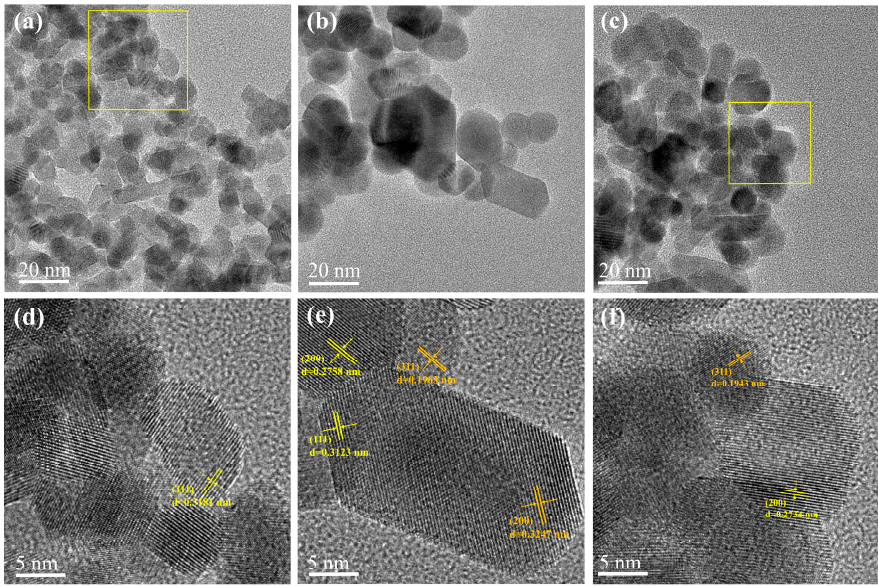
Figure 6. HRTEM of fresh samples ( a , d ) for CeO 2 ; ( b , e ) for 10%K/CeO 2 ; ( c , f ) for 20%K/CeO 2 .